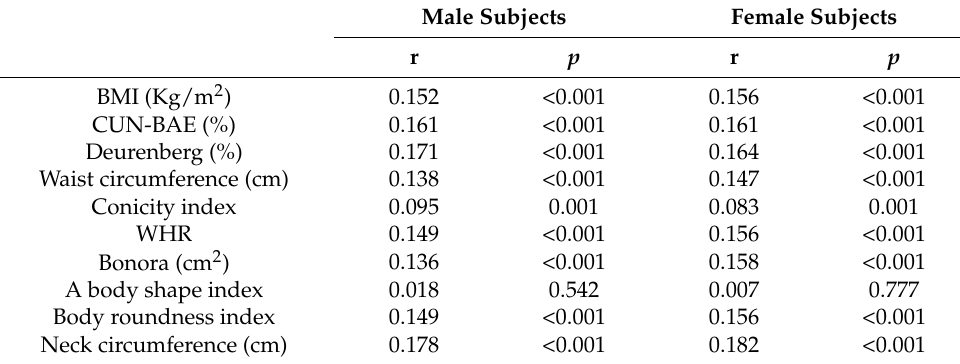
Table 3. Bivariate correlations of glycated hemoglobin with anthropometric indices in the participants with prediabetes according to sex distribution.